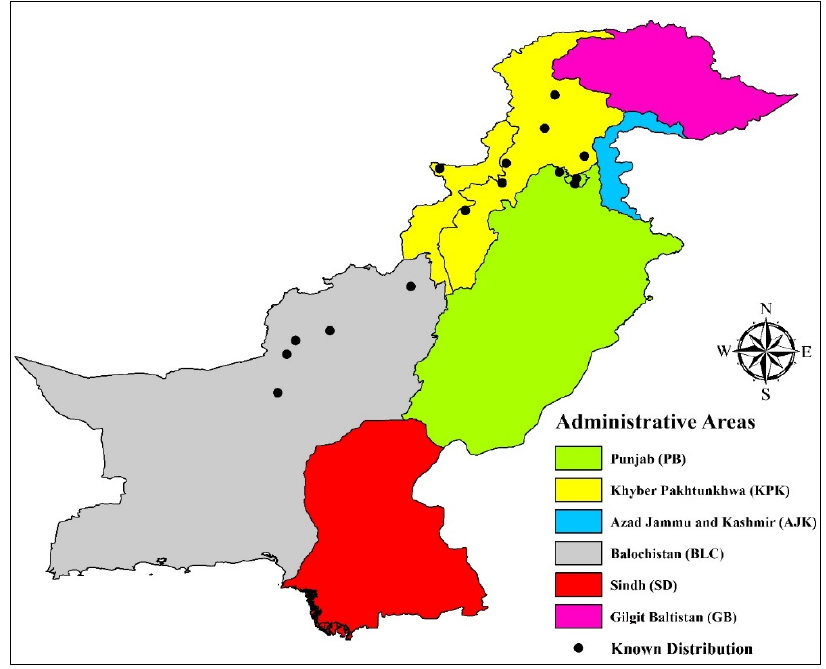
Figure 1. Map of Pakistan with six administrative areas (highlighted in six colors). Black dots represent the present known distribution of Aeolesthes sarta in Pakistan.